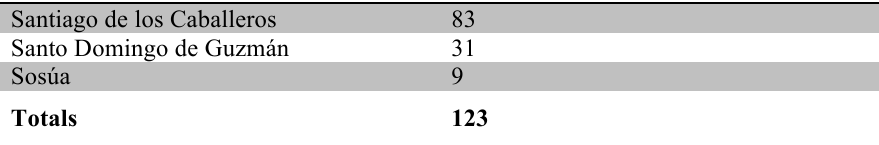
Table 1: Total number of participants in this